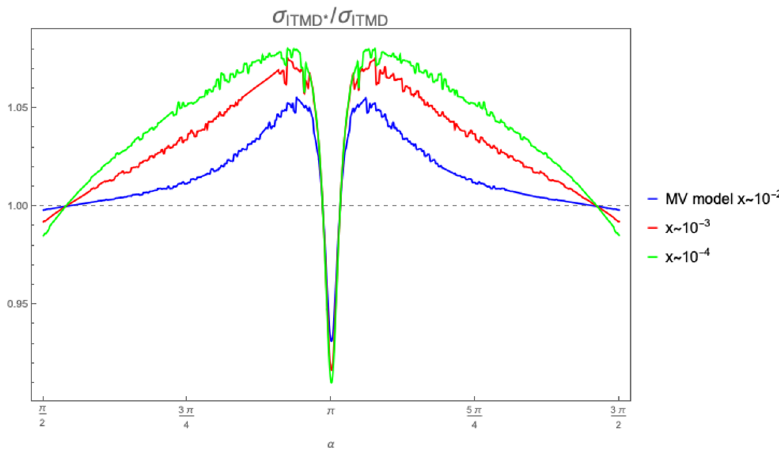
Figure 1 . Ratio of the γ ∗ A → Q ¯ QX cross sections calculated in the ITMD* and ITMD frame- T works, as a function of the angle α between the transverse momenta of the heavy quarks. Gluon TMDs are numerically evaluated in the MV model and evolved towards lower values of x with the JIMWLK